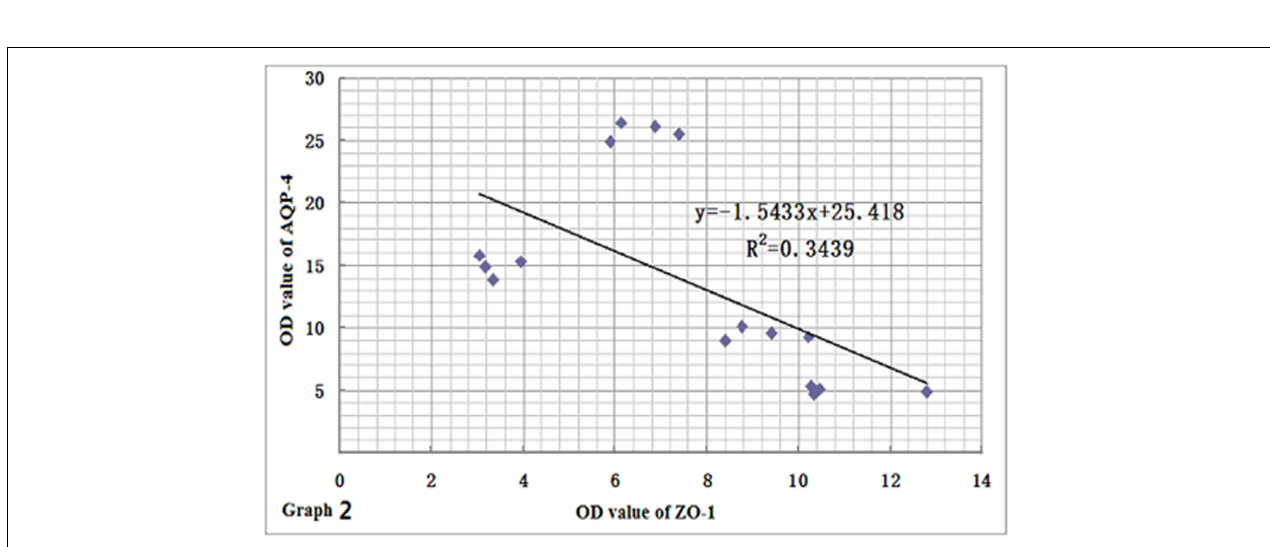
Frontiers in Pharmacology |